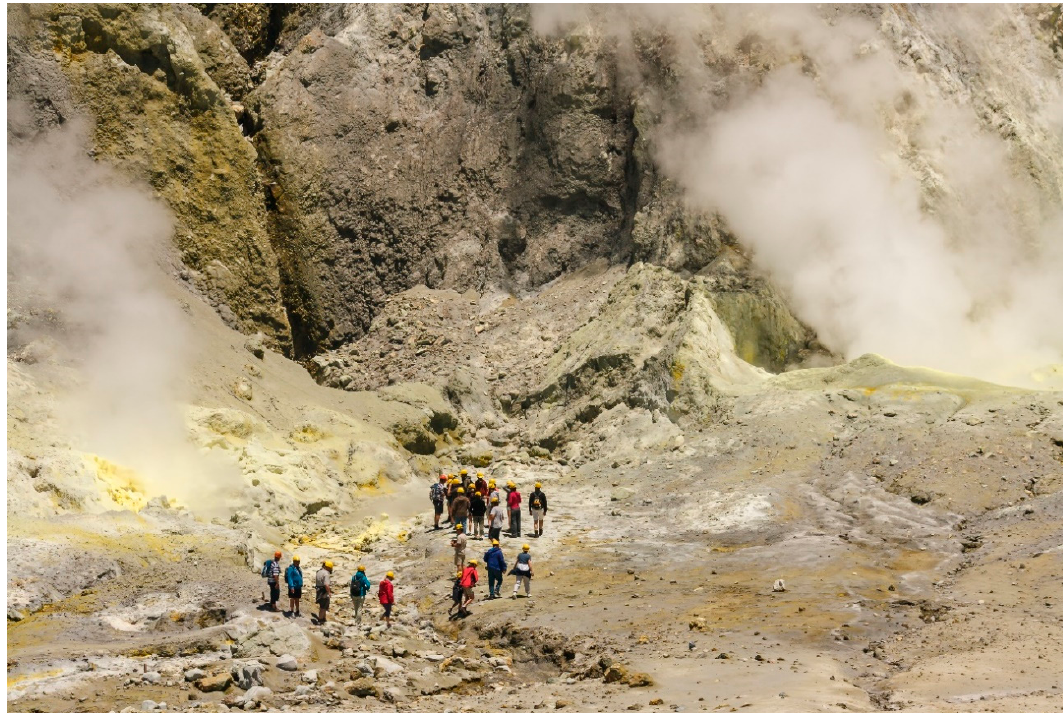
Figure 1. A tour group explores the fumarole field in the crater of Whakaari/White Island Volcano, New Zealand. Photo credit: Patjo/Shutterstock.com.